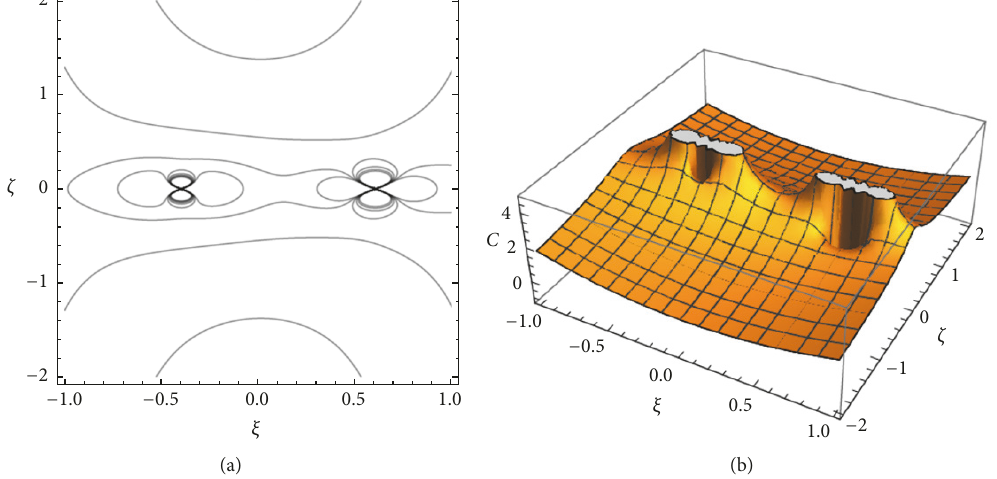
Figure 4: Zero-velocity curves in the ( 𝜉 − 𝜁 ) plane of PSR 1903+0327 for 𝐴 = 0.02,𝑎 = 0.95, 𝜎 1 = 0.01 and 𝜎 2 = 0.005 .